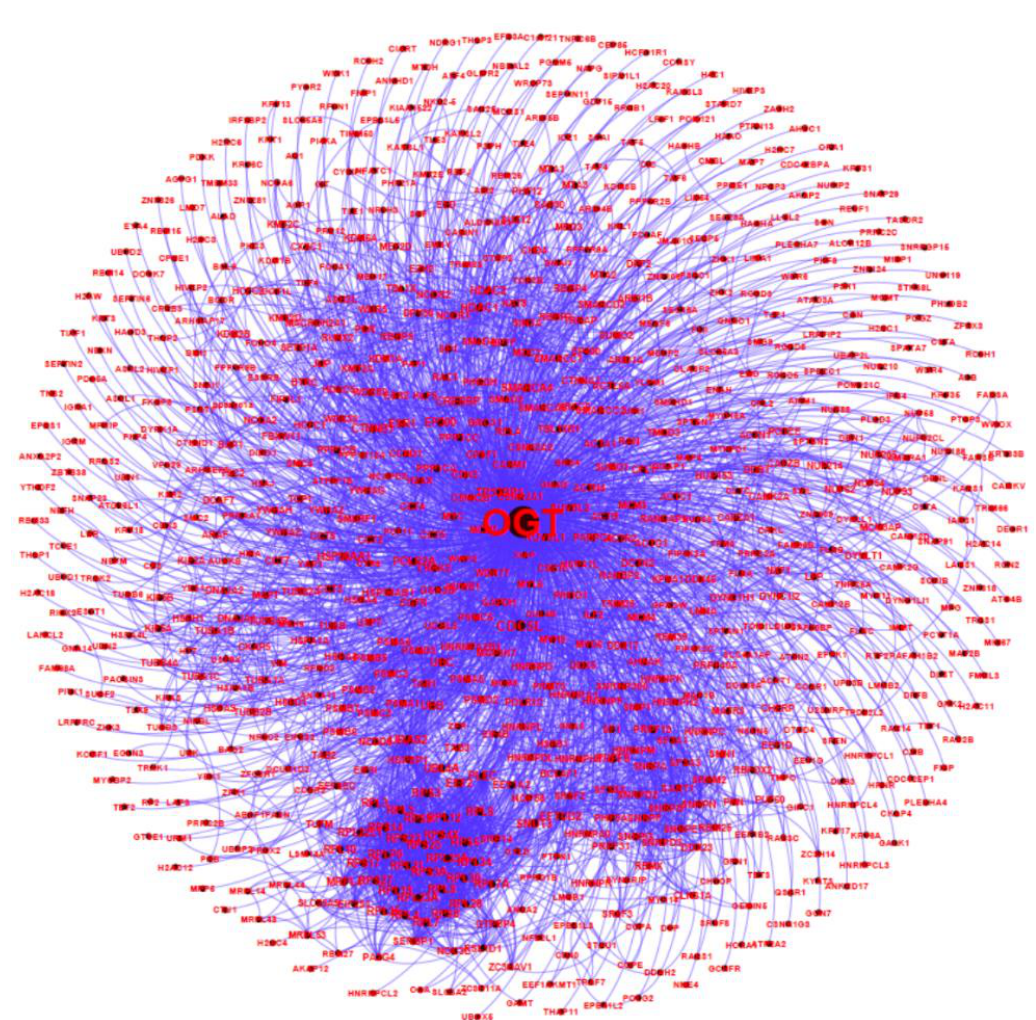
Figure 4. A human OGT interaction network consisting of 782 nodes and 4224 edges (protein interactions). Some nodes are shown in a bigger size due to their higher numbers of associations with other proteins. Table 1. A list of 18 human OGT-interacting proteins with the highest identification events.